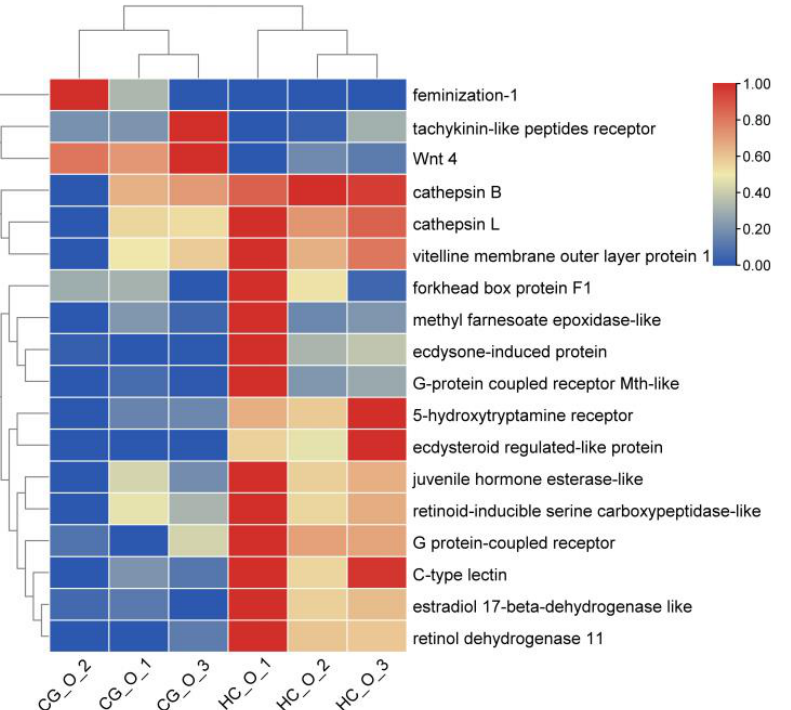
Figure 6. The heatmap of DEGs related to ovarian development in the HC_E vs. CG_E group.